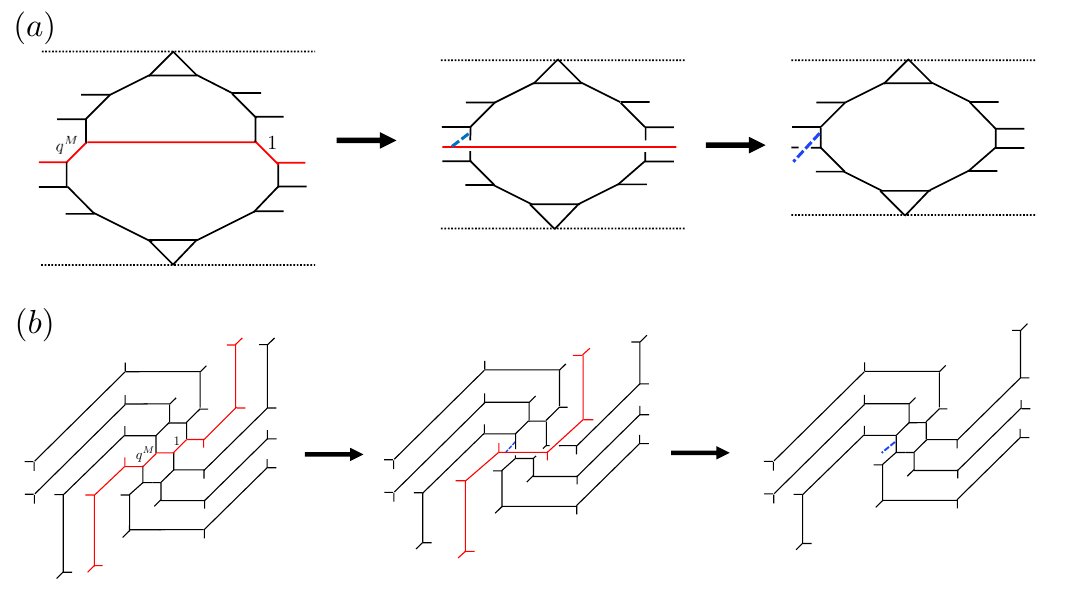
Figure 7 . The 5-branes with the defect introduced by defect Higgsing. The blue dashed lines denote the